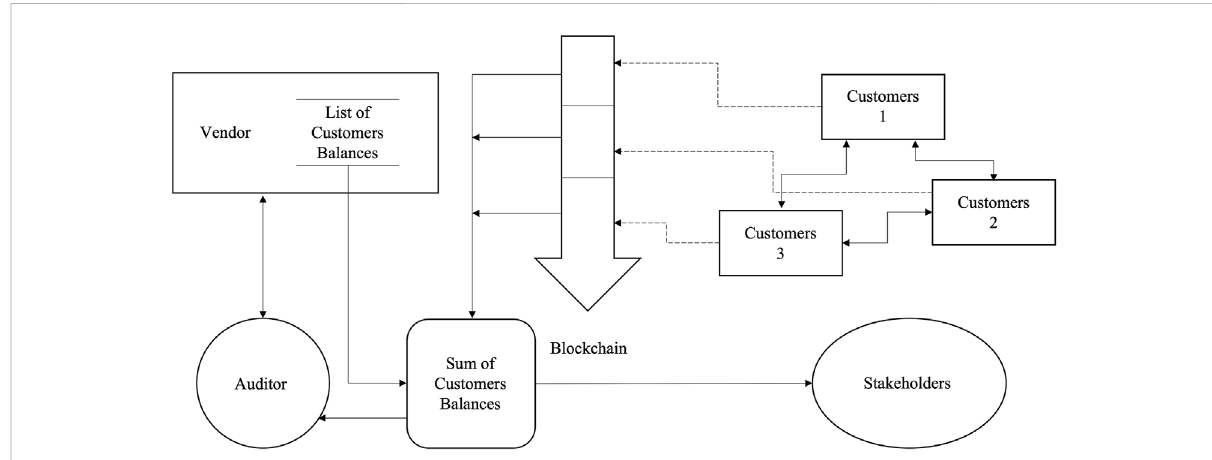
FIGURE 4 Public and private access for accounting information system (Fisher, 1922).